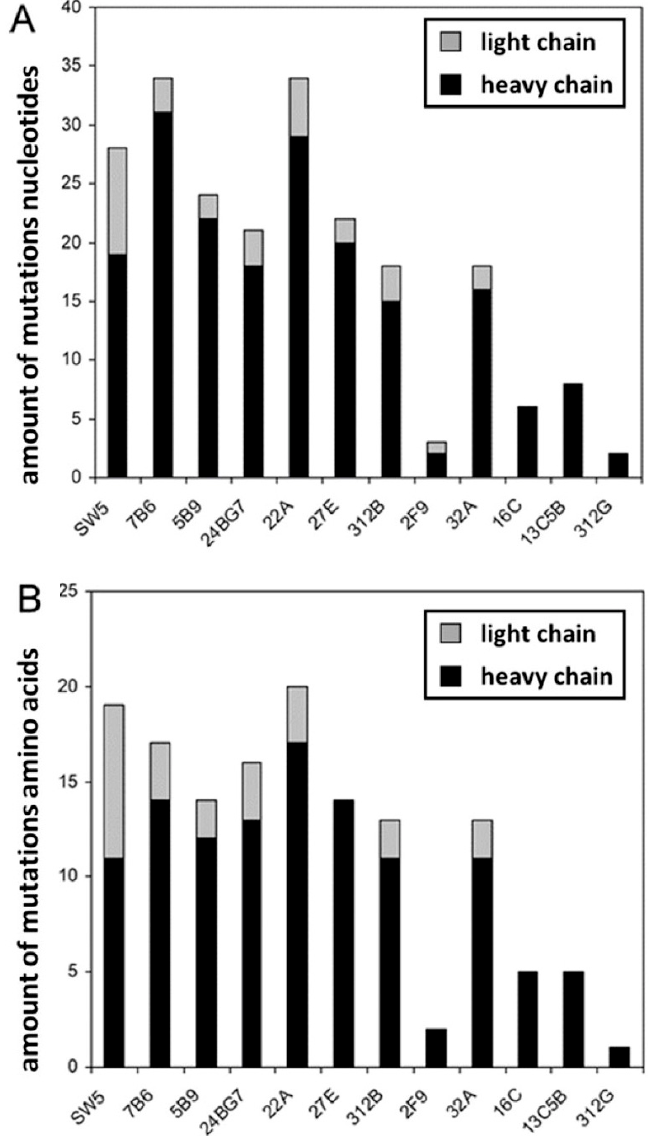
Figure 5. Estimation of mutations in the mabs. The total number of hypermutations present in the sequences of the light (grey) and heavy (black) chains were calculated for the respective ( A ) nucleotide or ( B ) aa sequence. Sequence differences in the region of the degenerated primers were not